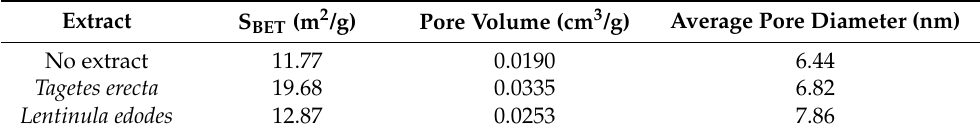
Figure 7. ( a ) Nitrogen adsorption–desorption (BET) isotherms and ( b ) BJH plots of ZnO nanoparticles obtained with ( ⎯ ) no extract, ( ⎯ ) Tagetes erecta , and ( ⎯ ) Lentinula edodes . Table 3. BET analysis surface area and porosity of ZnO nanoparticles.